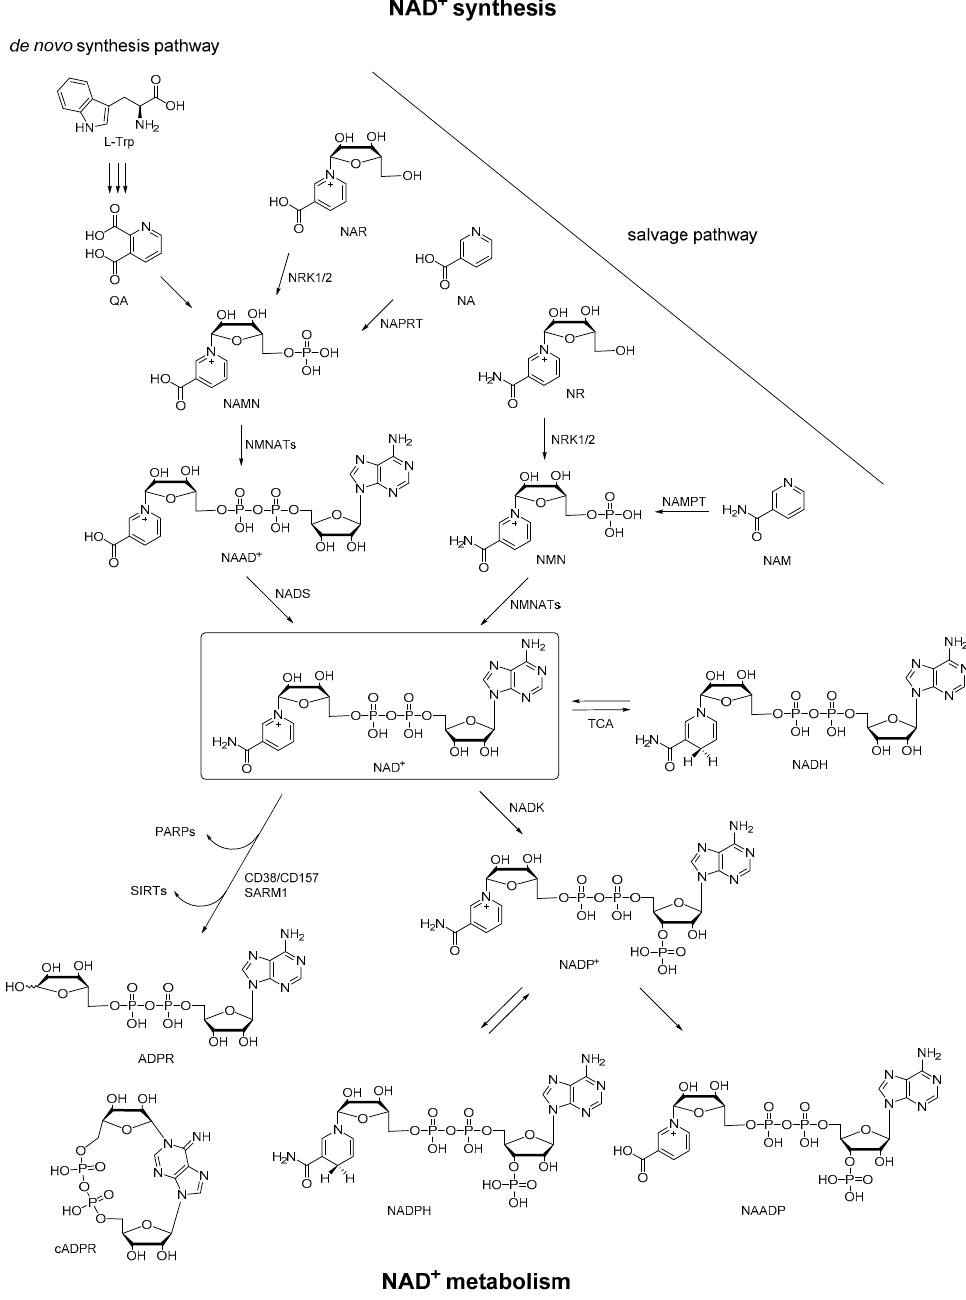
Figure 1. Pathways of NAD + synthesis and